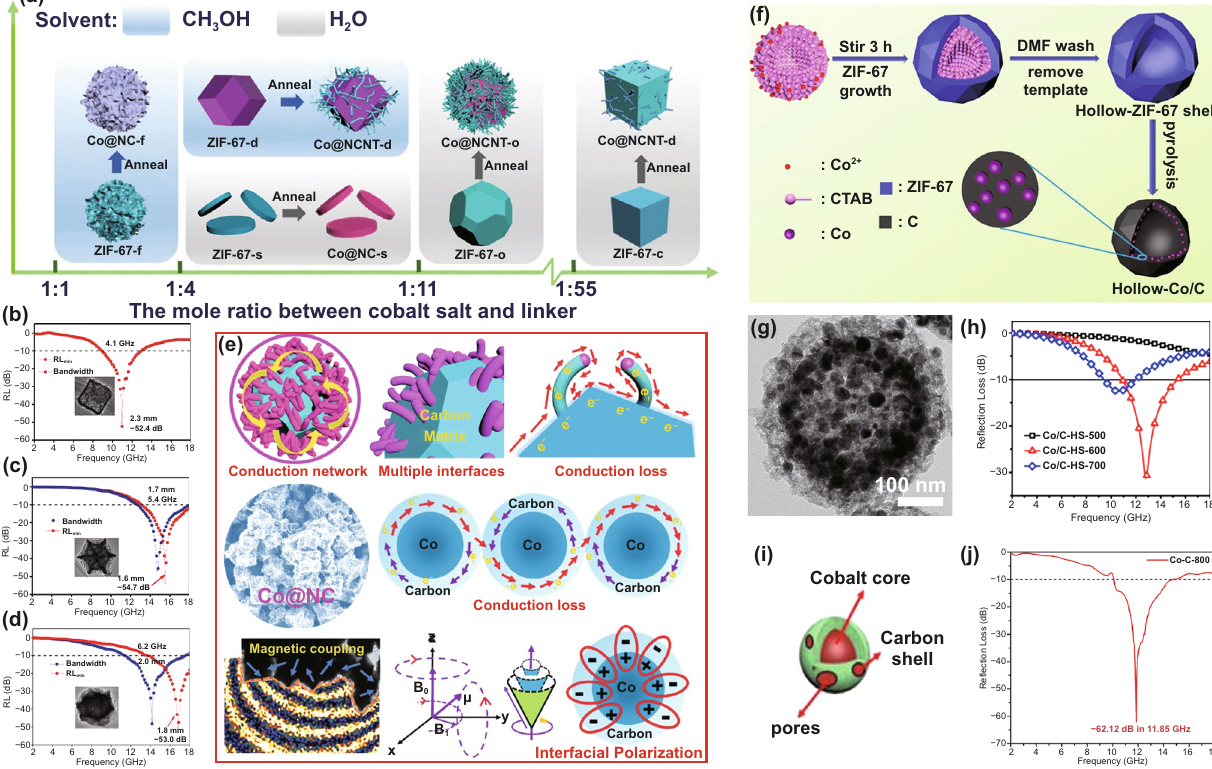
Fig. 5 a Schematic preparation process of Co@NCNT composites. RL-f curves of the b Co@NCNT-cube, c Co@NCNT-dodecahedron and d Co@NCNT-octadecahedron. e Microwave loss mechanism diagram of Co@NCNTs. Reprinted with permission from Ref. [85]. f The synthesis route, g TEM image and h RL-f curves of hollow Co/C microspheres. Reprinted with permission from Ref. [42]. i Structure diagram and j RL-f curve of C/Co composite. Reprinted with permission from Ref.